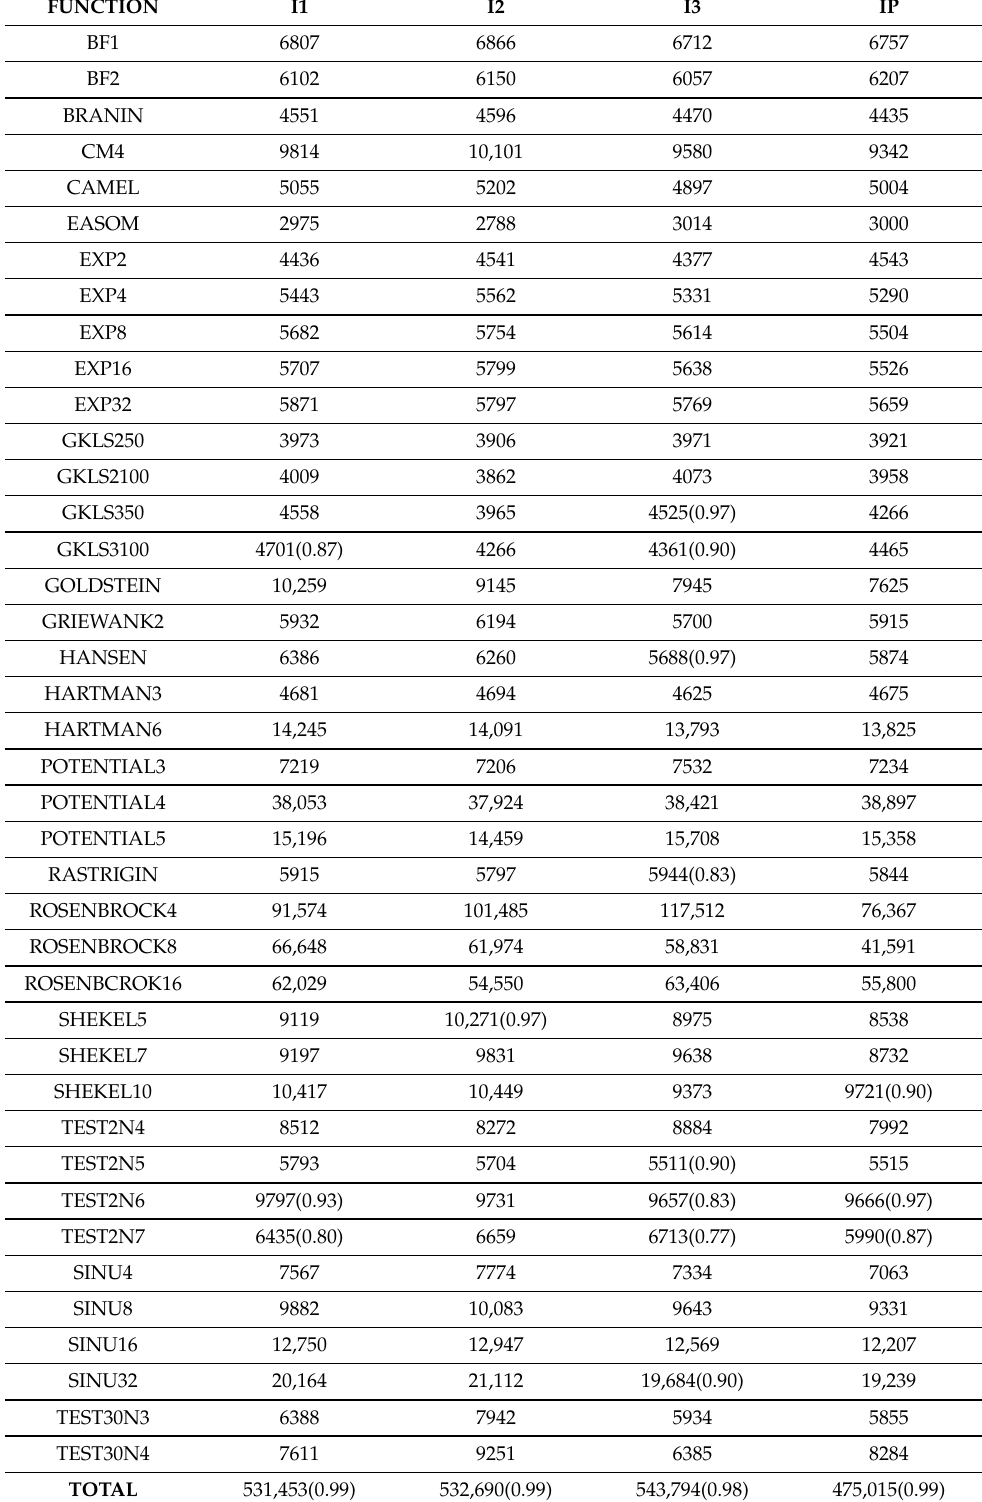
Table 4. Experiments with the double box stopping rule without gradient